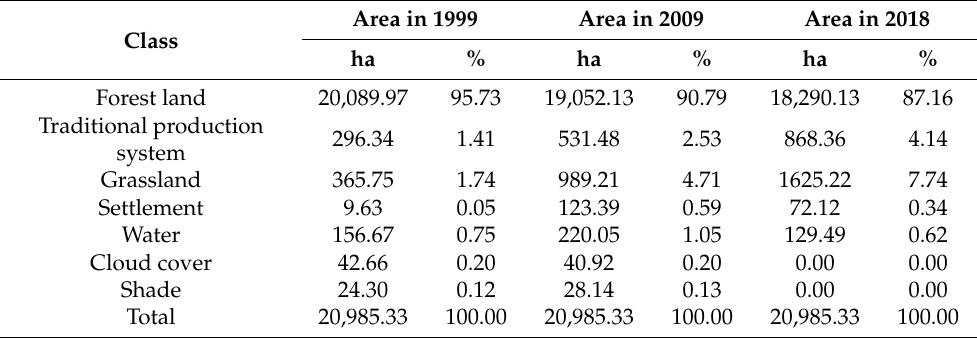
Table 4. LULC classification results of 1999, 2009, and 2018 images, showing the area of each class and percentages per class in the DLZ’s northern zone (Dayuma and Taracoa) in the Yasun í Biosphere Reserve of the Ecuadorian Amazon Region.